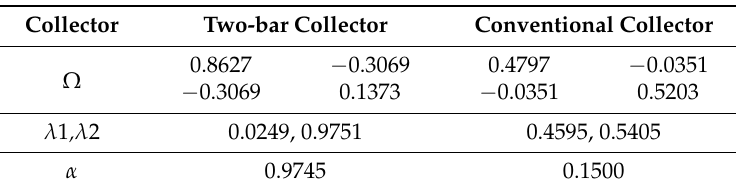
Table 1. Orientation matrices ( Ω ), Eigen values ( λ 1, λ 2) and anisotropy index ( α ) for the 2 bars collector, compared to conventional collector.